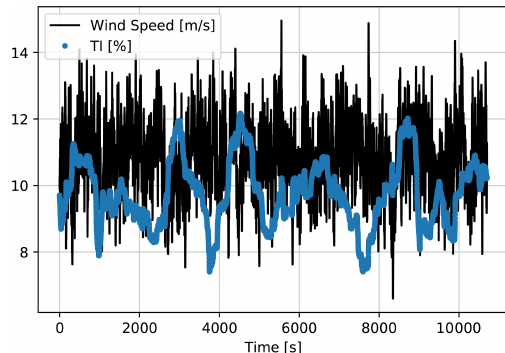
Figure 13. LSTM network training with further transfer learning input time series generated by HAWC2, down-sampled to 1Hz. Mean wind speed=11ms − 1 ; mean TI =